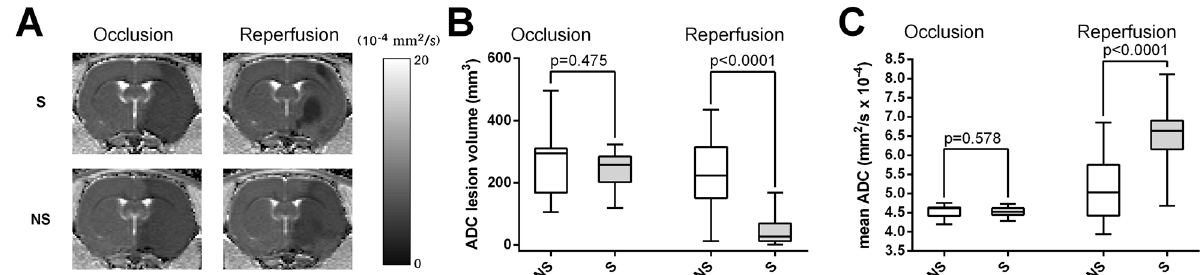
Figure 2. Apparent diffusion coefficient (ADC) maps show larger ischemic stroke volume at reperfusion in rats not surviving ischemia–reperfusion injury. ( A ) Representative ADC maps measured from a survival (S) rat (surviving ischemia–reperfusion injury) and from a non-survival (NS) rat (died at 48 h after reperfusion) during left middle cerebral artery occlusion (MCAO) and at reperfusion. ( B ) Summary data of differences between survival (S) and non-survival (NS) rats (n = 46, n = 13 respectively) in ADC lesion volume (mm 3 ) during occlusion of left middle cerebral arteries and at reperfusion. ( C ) Differences between survival (S) and non-survival (NS) rats in mean ADC of the initial lesion site (mm 2 /s × 10 –4 ) during occlusion of left middle cerebral arteries and at reperfusion. Whiskers are set at minimum and maximum, the horizontal line marks the median, whereas box indicates the interquartile range (25–75%). 2-sided exact p-values are based on Mann– Whitney